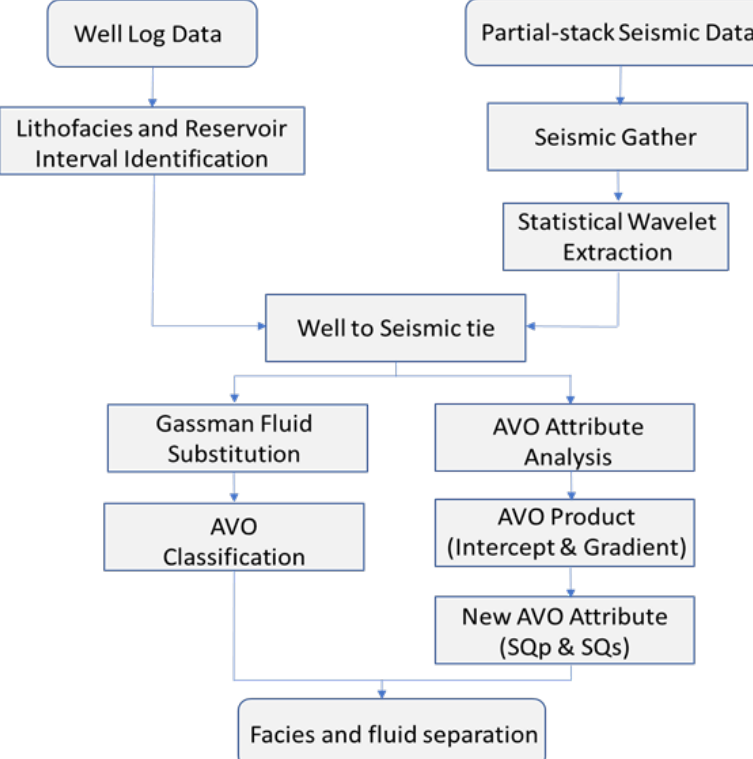
Figure 3. Amplitude versus offset (AVO) modeling workflow for facies and fluid identification.